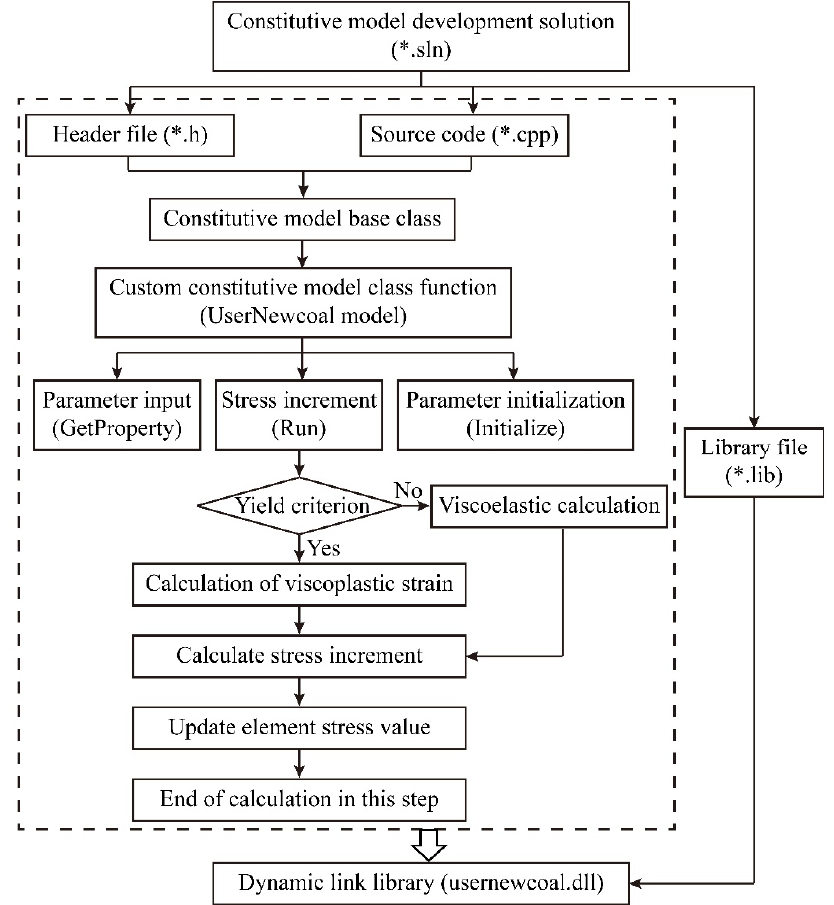
Figure 13. Compilation